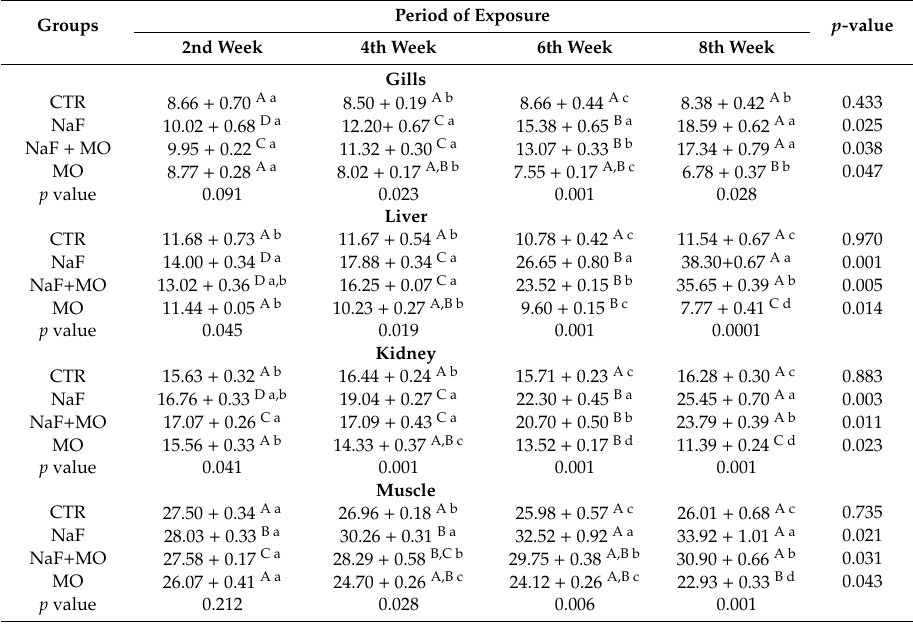
Table 4. E ff ect of Sodium fluoride (NaF) and / or M. Oleifera (MO) on malondialdehyde (MDA) (U / g